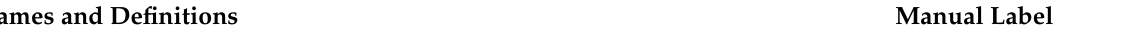
Table 1. Category Names, definitions, manual label numbers, and number of tweets of each category. Names and